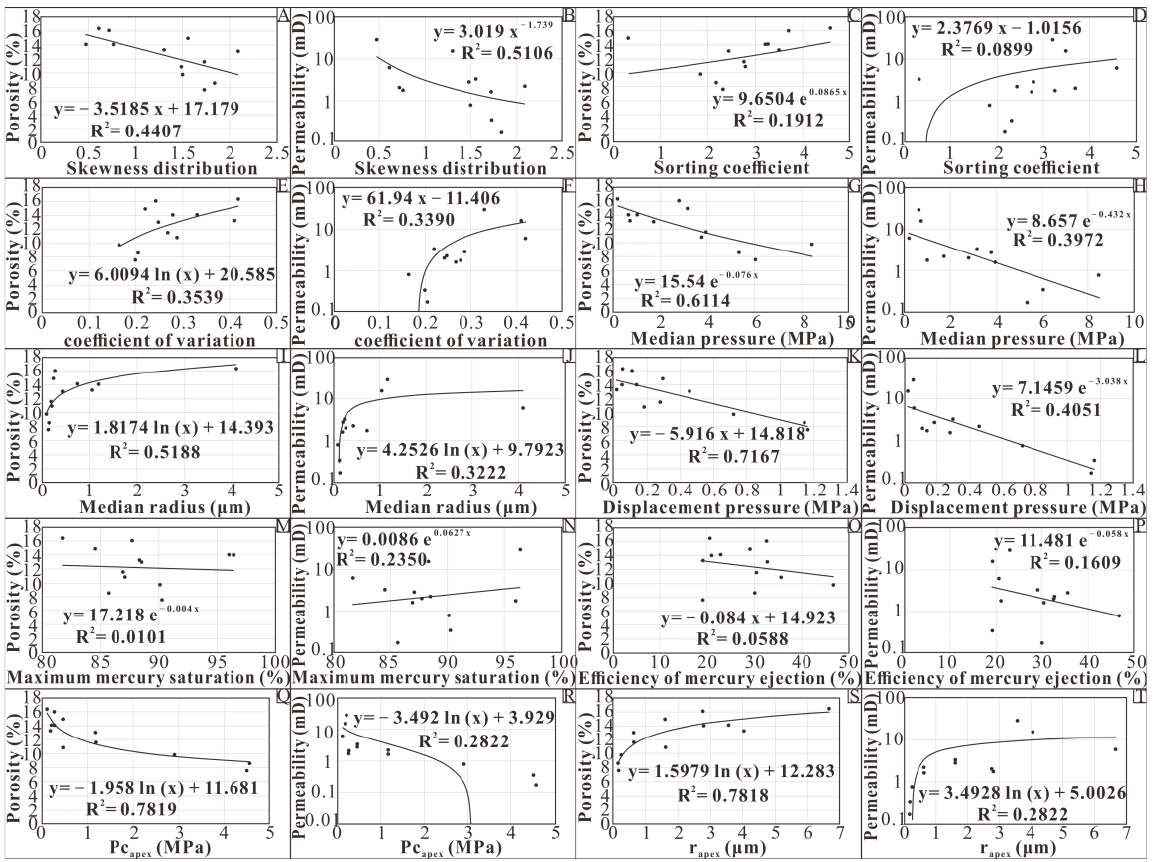
Figure 16. Correlation between pore-throat structure and reservoir quality. ( A , B ) Correlation between skewness distribution and physical property. ( C , D ) Correlation between sorting coefficient and physical property. ( E , F ) Correlation between coefficient of variation and physical property. ( G , H ) Correlation between Median pressure and physical property. ( I , J ) Correlation between Median radius and physical property. ( K , L ) Correlation between displacement pressure and physical property. ( M , N ) Correlation between maximum mercury saturation and physical property. ( O , P ) Correlation between efficiency of mercury ejection and physical property. ( Q , R ) Correlation between Pc apex and physical property. ( S , T ) Correlation between r apex and physical